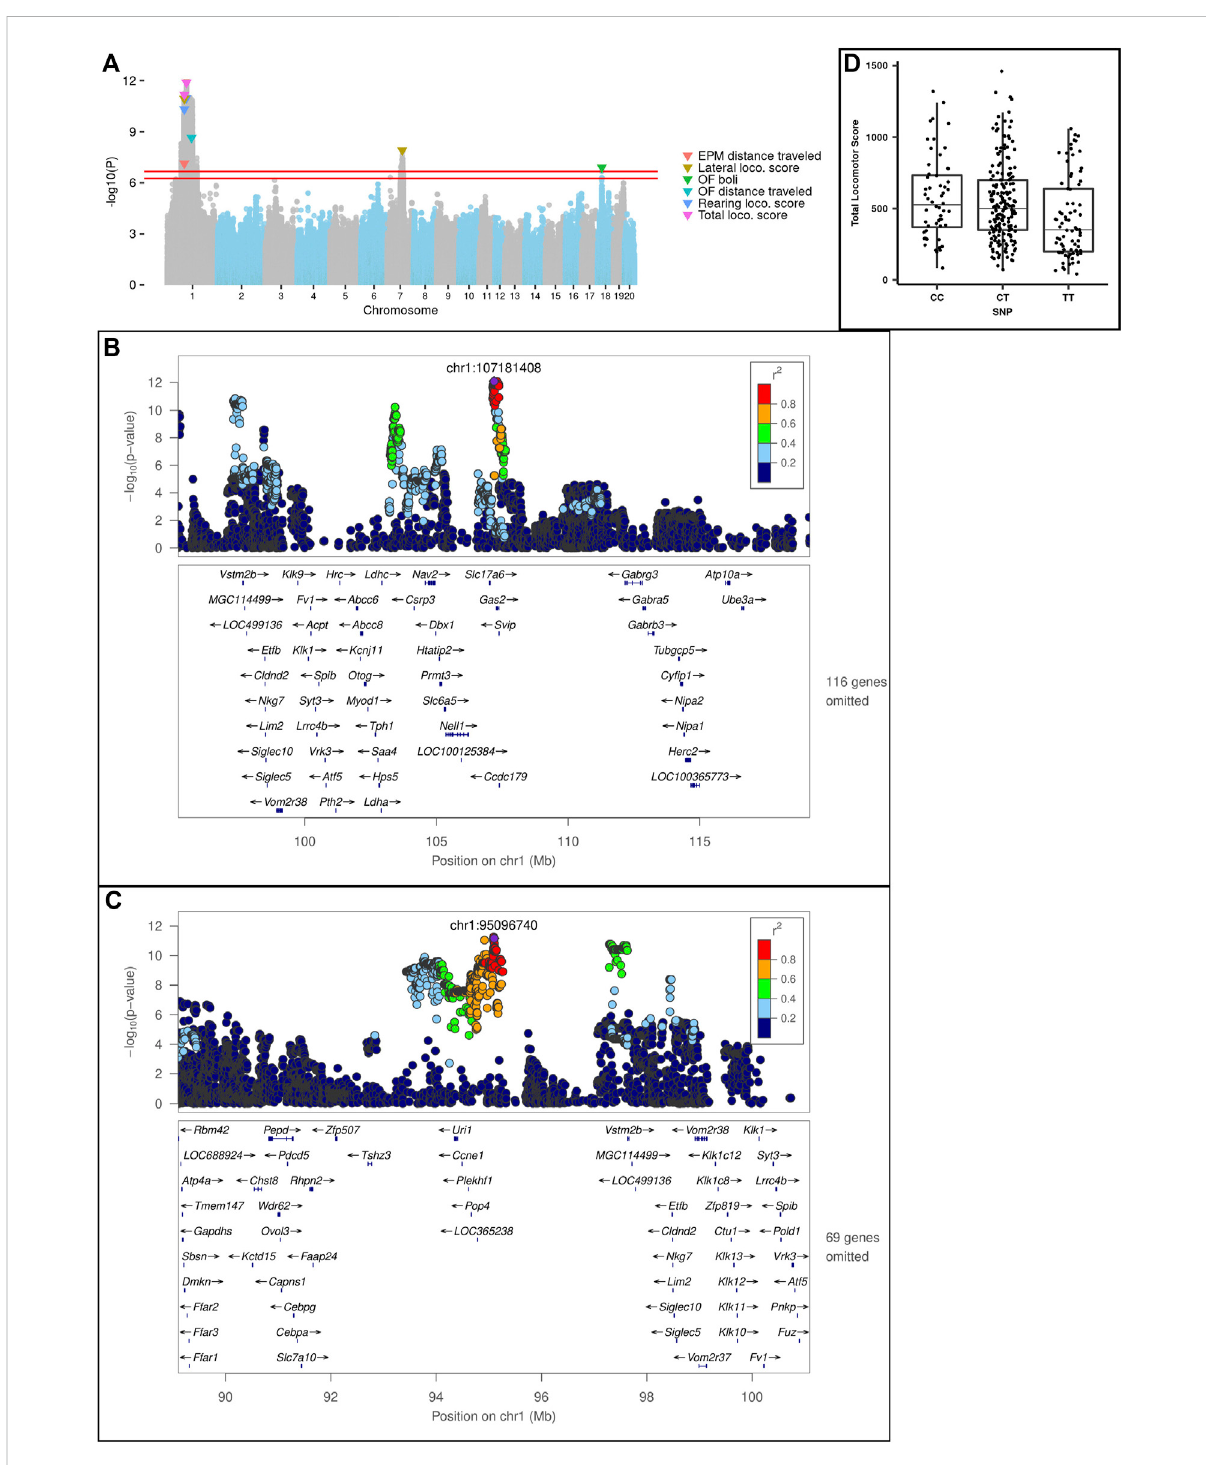
FIGURE 8 (A) Porcupine plot for Locomotor score, EPM and OF traits. Genome-wide association results from the GWA analysis. The chromosomal distribution of all the p -values ( − log 10 ( p ) values) is shown, with top SNPs highlighted. The red lines show the threshold for signi fi cance. For EPM and Locomotor scores (i.e., LocoScore), the signi fi cance threshold was − log 10 ( p ) = 6.664 and for OF traits the threshold was − log 10 ( p ) = 6.254. (B) Regional association plot for Lateral locomotor score QTL on chr1: 107 Mb. (C) Regional association plot for Total locomotor score QTL on chr1:95 Mb. X-axis shows chromosomal position. The SNPs with the lowest p -value ( “ top SNP ” ) is shown in purple, and its chromosomal position is indicated on the plot. Color of the dots indicates the level of linkage disequilibrium (LD) of each SNP with the top SNP. Genes in the region, as annotated by the RefSeq. (D) Effect plot for Total locomotor score QTL on chr1:95 Mb. Effect plot depicting the genetic effect of the peak SNP chr1: 95 Mb with a signi fi cant association to Total Locomotor